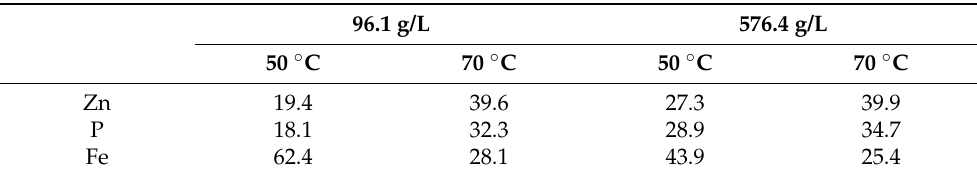
Table 9. Average corrosion data obtained from the polarization curves performed in 0.1 M Na 2 SO 4